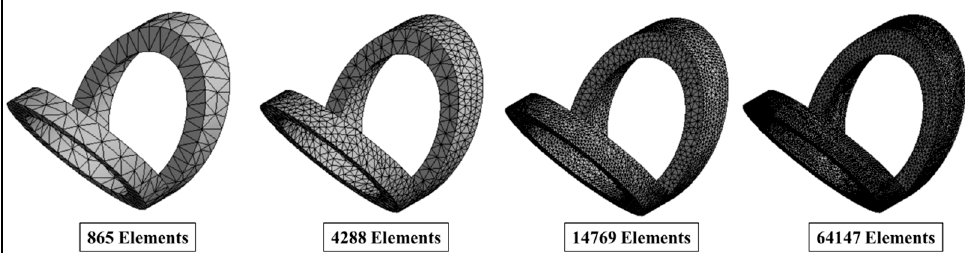
Figure 5. Different meshes, from very coarse to superfine, with the number of elements .